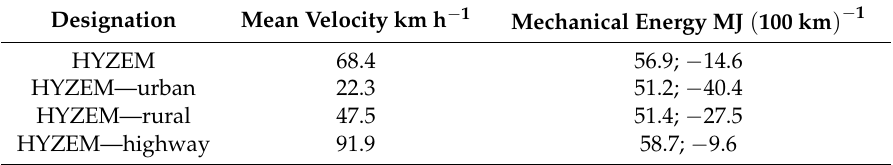
Table 6. Characterization of driving cycles used. The mechanical energy consumption is given for positive and negative tractive forces. A total of 25 drive cycles were used for the